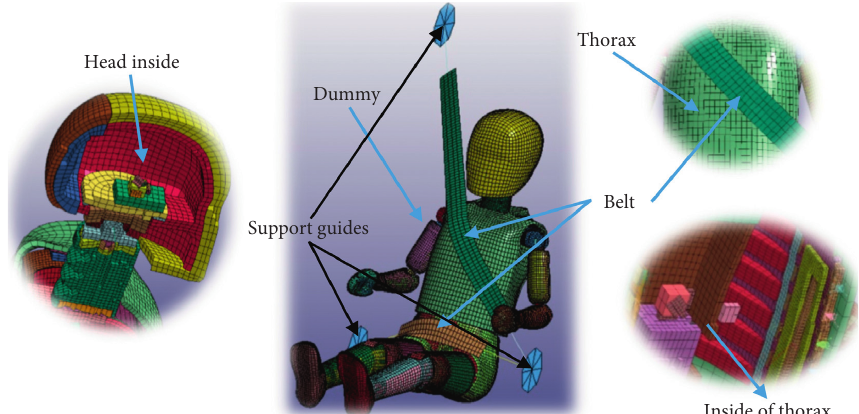
Figure 2: Mesh size composed of 8mm 3D hexahedral and 2D quadratic